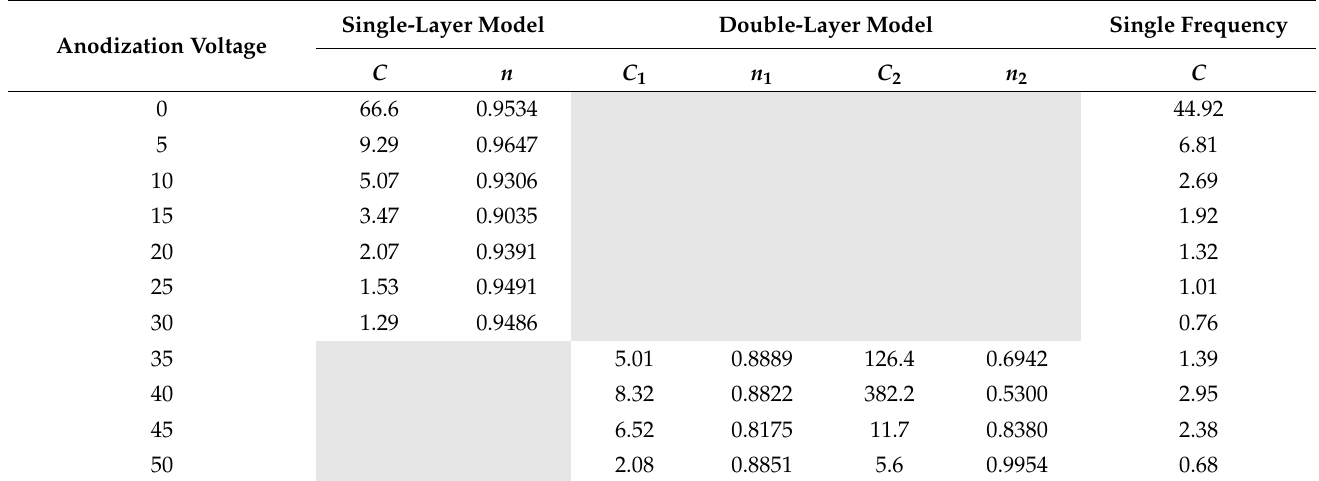
Table 3. Values for oxide capacitance C x and parameter n (in all cases C in µ F · cm − 2